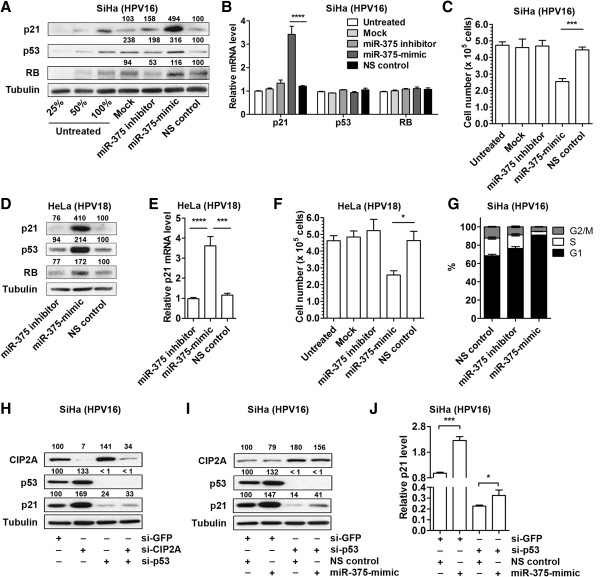
miR-375 increases p21, p53, and RB in HPV16- and 18-positive cancer. (A) Protein levels of p21, p53, and RB in SiHa cells transfected with miR-375 inhibitor, -mimic, or NS control were measured by Western blot analysis. 25%, 50%, 100% amounts of untreated cell lysates were included to calibrate the semiquantitative measurement. (B) Relative endogenous mRNA levels of p21, p53, and RB were measured in SiHa cells transfected with miR-375 inhibitor, -mimic, or NS control using qRT-PCR. (C) One hundred thousand SiHa cells were seeded on 24-well plate and the number of cells was counted by trypan blue exclusion staining assay 48 h post-transfection. (D) Protein levels of p21, p53, and RB in HeLa cells transfected with miR-375 inhibitor, -mimic, or NS control were measured by Western blot analysis. (E) Relative p21 mRNA levels were measured in HeLa cells transfected with miR-375 inhibitor, -mimic, or NS control. (F) Trypan blue exclusion staining assay was used to analyze the proliferation rate of HeLa cells 48 h post-transcfection. (G) Flow cytometry analysis demonstrates G1 arrest of SiHa cells 48 h after transfection with miR-375-mimic compared to miR-375 inhibitor or NS control. (H) Protein levels of CIP2A, p53, and p21 in SiHa cells transfected with si-CIP2A and/or si-p53 were measured by Western blot analysis. (I) Protein levels of CIP2A, p53, and p21 in SiHa cells transfected with si-p53 and/or miR-375-mimic were measured by Western blot analysis. (J) mRNA levels of p21 in SiHa cells transfected with si-p53 and/or miR-375-mimic were measured by qRT-PCR. The concentrations of siRNA or miRNA used in panels H, I, and J were 10 nM and 25 nM, respectively. Results are expressed as mean ± SD from three independent experiments. *p < 0.05, ***p < 0.001, and ****p < 0.0001.